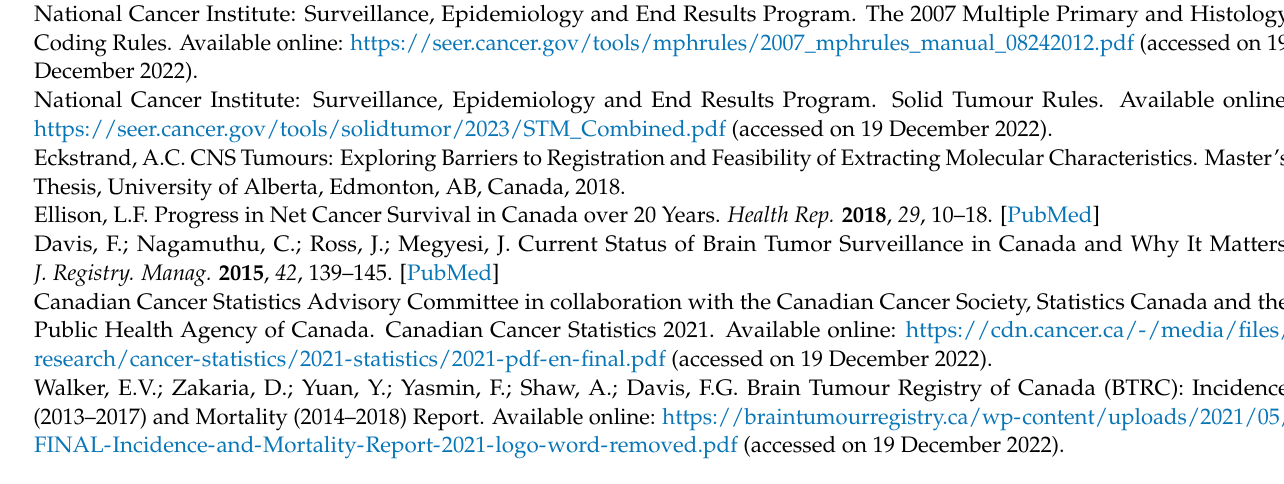
Table S1: Proportion of unclassified primary CNS tumours diagnosed in Canada (excluding Quebec) between 2008 and 2017 by province and tumour